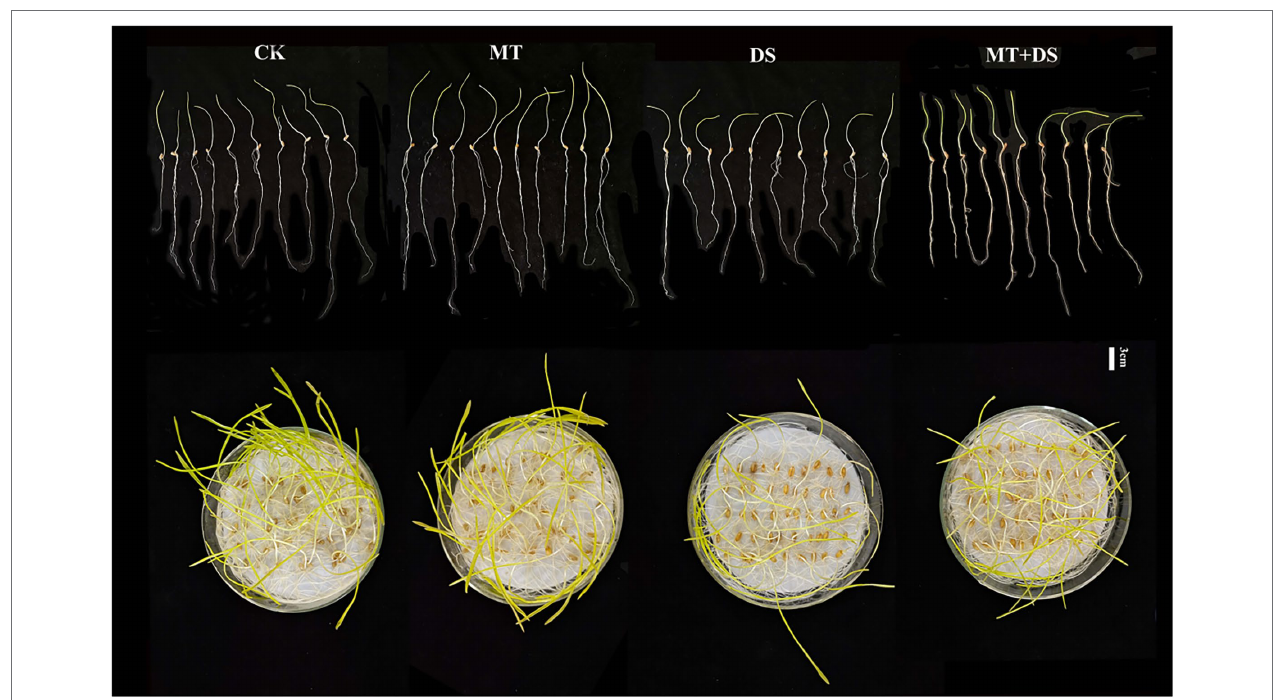
FIGURE 2 | Phenotypic traits of germ and radicle of triticale seeds cultured in Petri dish for 7